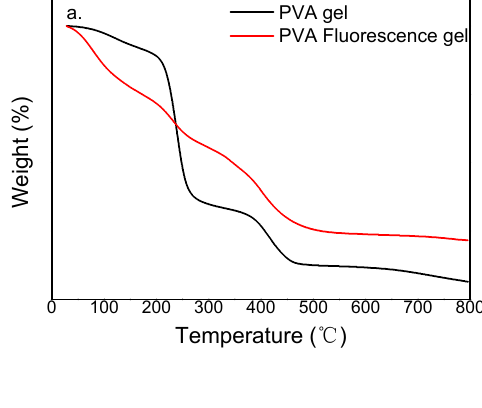
Figure 9. Fluorescence emission intensity of PVA fluorescence gel for different Eu 3+ :Tb 3+ ratios.